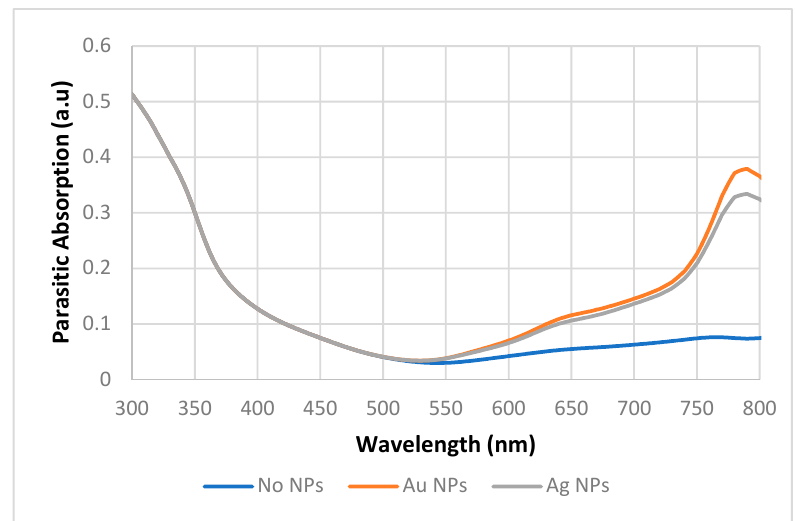
Figure 9. Parasitic absorption plot for the cell with and without Au and Ag NPs.